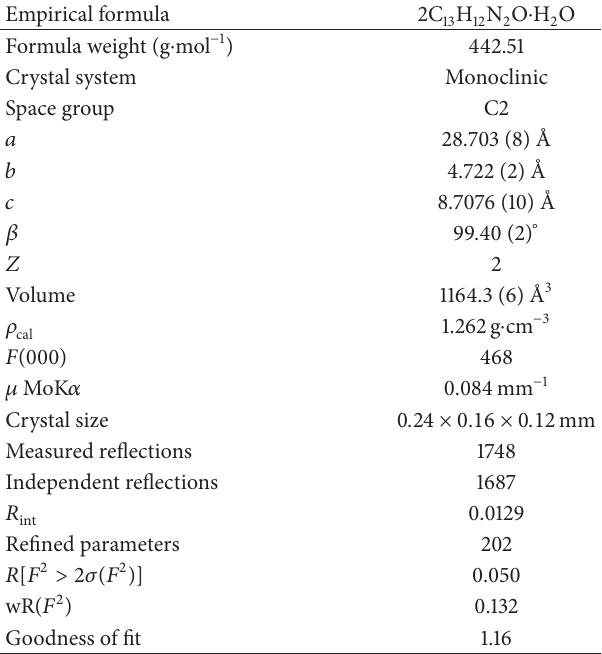
H N O ⋅ H O. Table 2: Hydrogen bond geometry (˚A, ∘ 13 12 2 2